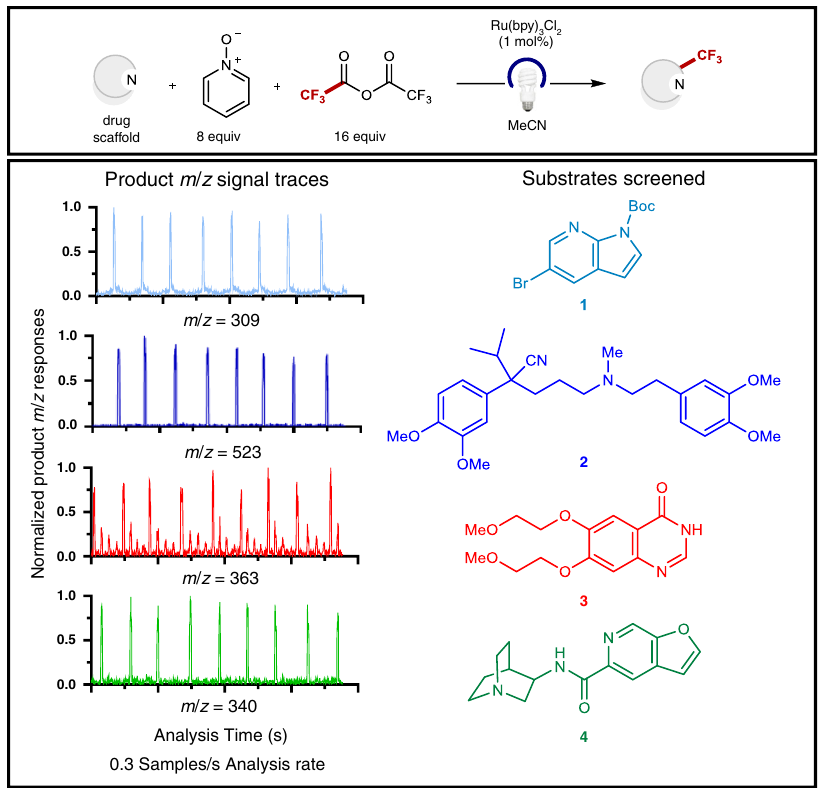
Fig. 2 ESI-MS analysis of in-droplet tri fl uoromethylation reactions. MH + molecular ions were monitored for all tri fl uoromethylated products except for 1, which was prominently observed as a m / z = 309 fragment. Ru(bpy) 3 Cl 2 tris(bipyridine)ruthenium(II)